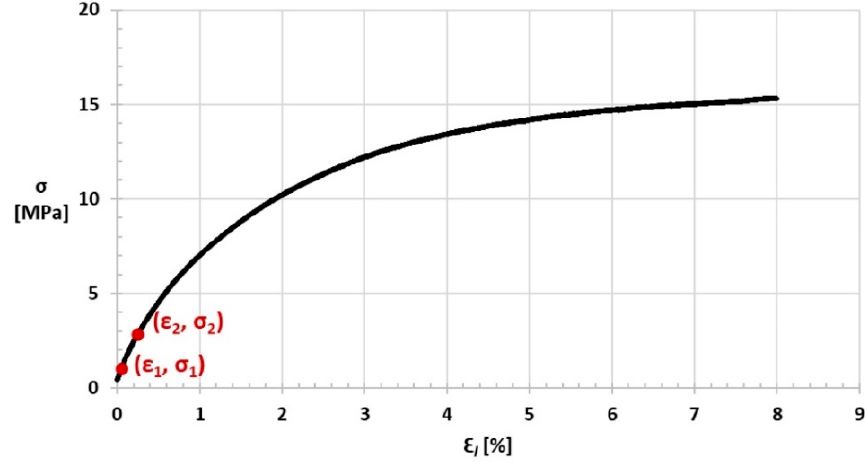
Figure 22. Stress σ relation to ε l strain graph (points to determine the tensile modulus E t are selected).